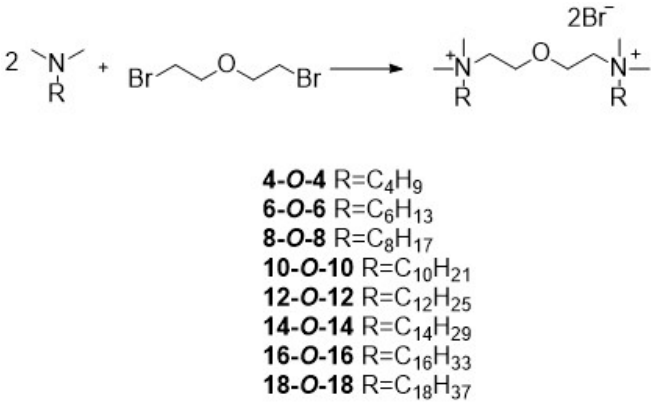
Figure 1. Synthesis of 3-oxa-1,5-pentane- bis ( N -alkyl- N , N -dimethylammonium bromides). The purities for all products were confirmed by elemental analysis (EA):